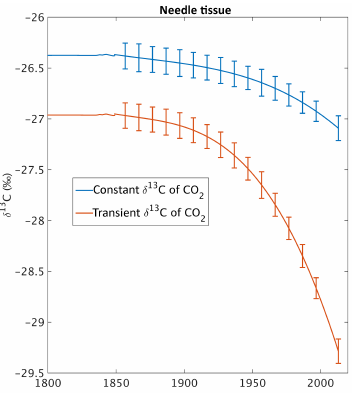
Figure 6. Simulation of δ 13 C of needle tissue using the limited nitrogen (default) CLM run. In the constant δ 13 C of CO 2 ( δ atm ) simulation the model boundary condition was − 6‰, whereas the transient δ atm simulation varied over time (Fig.